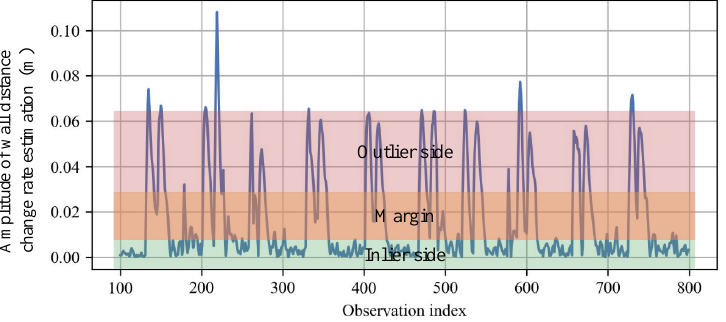
Figure 6. Judgment margin. The plot shows the amplitude of wall distance change rate ˆ ν n | n estimated on the wall distance observations in Figure 5. The amplitudes of outlier observations are much greater than the inlier ones, thus the judgment threshold T ν is easily selected from the margin